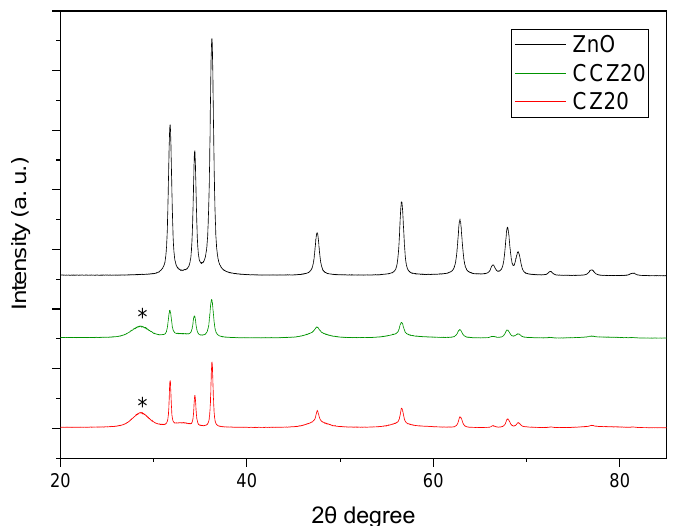
Figure 2. XRD pattern of bare ZnO and CeO 2 -ZnO precipitated with carbonates (CCZ20) and NaOH (CZ20).